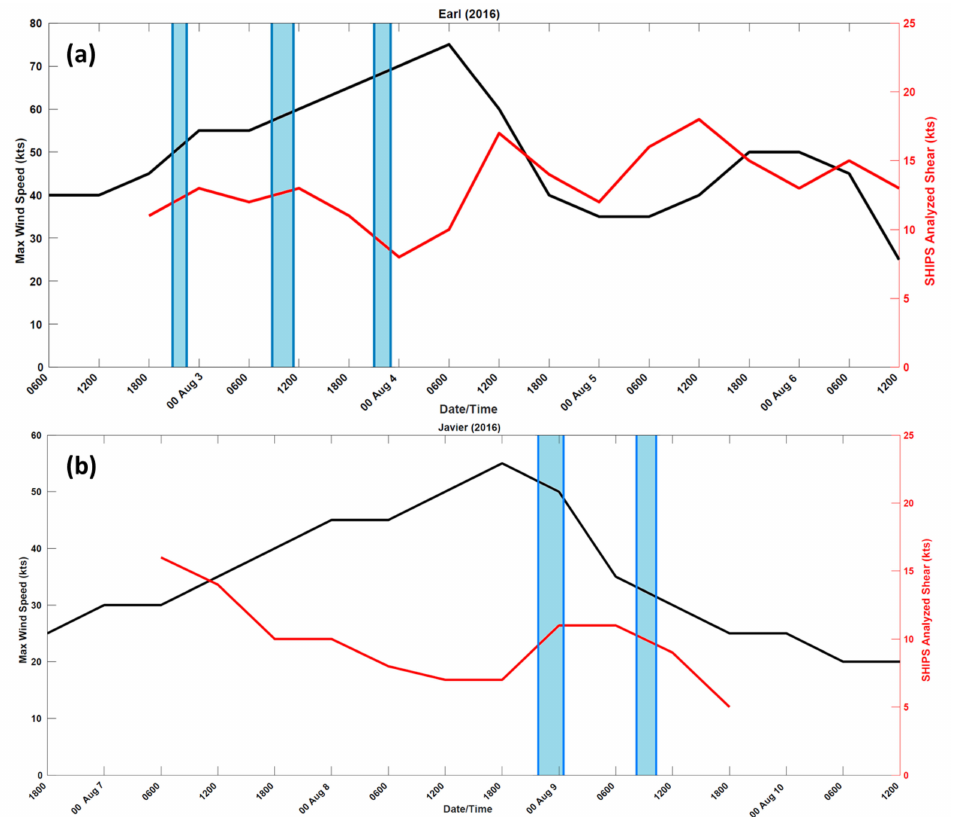
Figure 2. Plots of the best track intensity (black) and the Statistical Hurricane Intensity Prediction Scheme (SHIPS) diagnosed shear (red) for ( a ) Hurricane Earl and ( b ) Tropical Storm Javier. Blue highlighted regions indicate the P-3 was in the storm